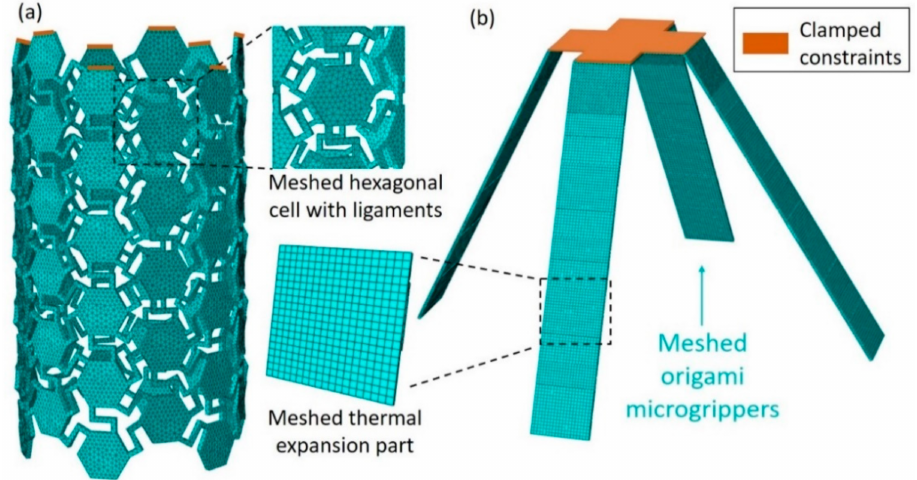
Figure 3. Numerical models of the ( a ) chiral tube subjected to the temperature range of 0–5 °C and ( b ) origami microgripper under the temperature range of 0–70 °C. Table 2. Geometric and material properties and loading conditions of the chiral tube and origami microgrippers. Material